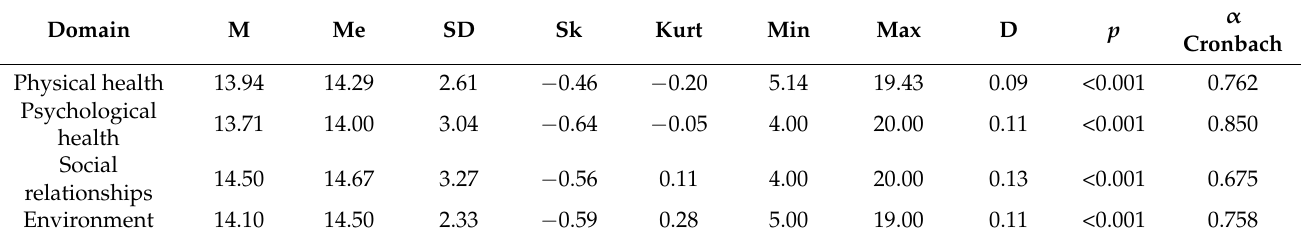
Table 2. Descriptive statistics with the test for normality of distribution and reliability of the